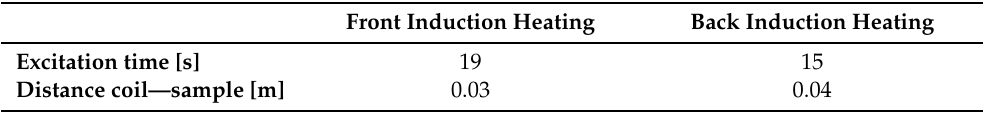
Figure 9. Processed data images from experiments performed using back heating. During experiment ( A ) an induction time of 4 s is used, during experiment ( B ) this is 8 s, and experiment ( C ) is performed using 15 s of heating. Table 7. Best parameters found during the measurements on the A-series samples. The samples of the B series are inspected using these